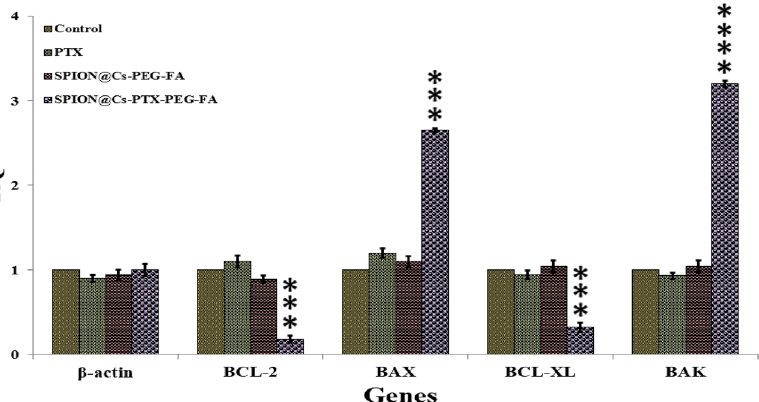
Figure 16. Gene expression of BCL-2, BAX, BCL-XL, and BAK analyzed in four groups of WEHI-164 cells. In each group, the first column represents control cells, the second represents cells treated with PTX, the third represents cells treated with SPION@Cs-PEG-FA, and the fourth represents cells treated with SPION@Cs-PTX- PEG-FA. The values in the graph indicate the mean ± SD. ***p < 0.001, ****p < 0.0001 indicate significant differences between the control (untreated) and other